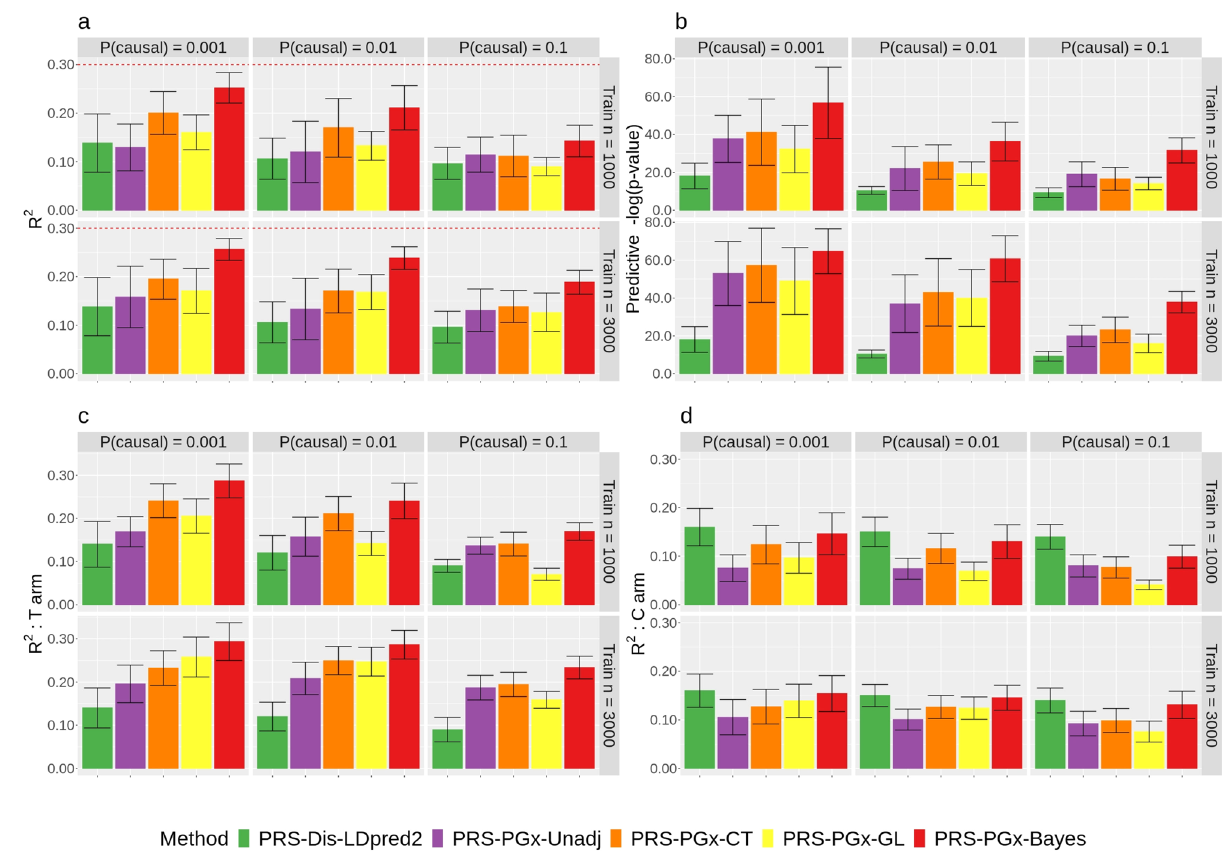
Fig. 2 | Predictive performance of fi ve polygenic prediction methods in the simulationstudies, where heritability was fi xedat0.3 and ψ / ξ =1. The numbers of the causal variants for P(causal)=0.001, 0.01, and 0.1 were 5, 50, and 500, respectively. The training sample size for PRS-PGx approaches was either 1000 or 3000; for PRS-Dis-LDpred2 approach was 20,000. The tuning parameters were